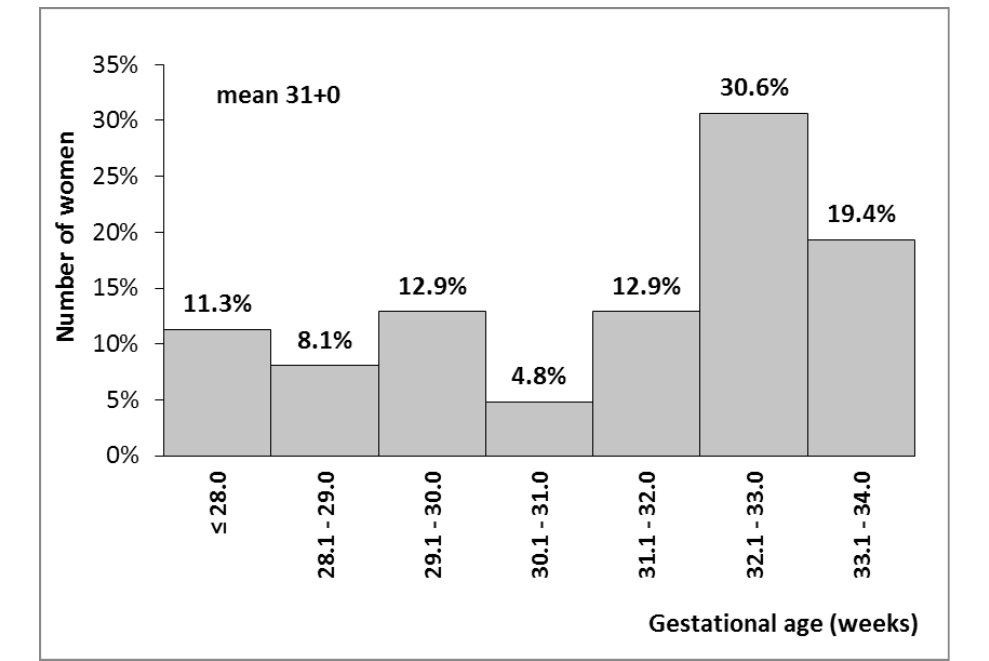
Fig. 1. Distribution of women according to gestational age at PPROM.